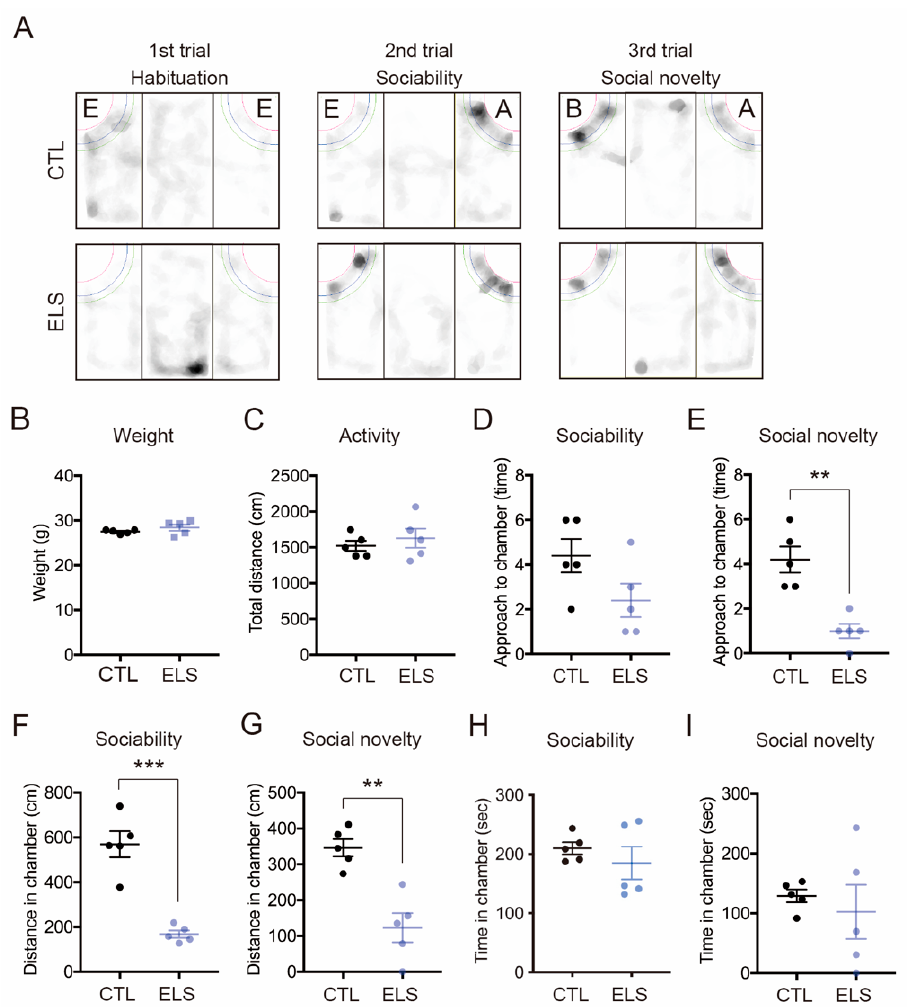
Figure 3. ELS distinctively affected social behaviors in mice. ( A ) Mount graph showing behavioral trace examples in the three ‐ chamber social interaction test. E, empty; A: stranger mouse 1; B: stranger mouse 2. ( B – I ) Reduced social behavior was observed in ELS mice. There was no difference in weight ( B ) or total distance ( C ) in the three ‐ chamber social interaction test. ( D – I ) The number of approaches ( D ), time ( F ), and distance ( H ) is shown during the 2nd trial (sociability behavior) ( D , F , H ) and the 3rd trial (social novelty behavior) ( E , G , I ), respectively. CTL, control mice; ELS, early life stressed mice. Data are represented as the means (±SEM). Asterisks indicate *** P < 0.001, ** P < 0.01, unpaired t ‐ test, n = 5/condition.